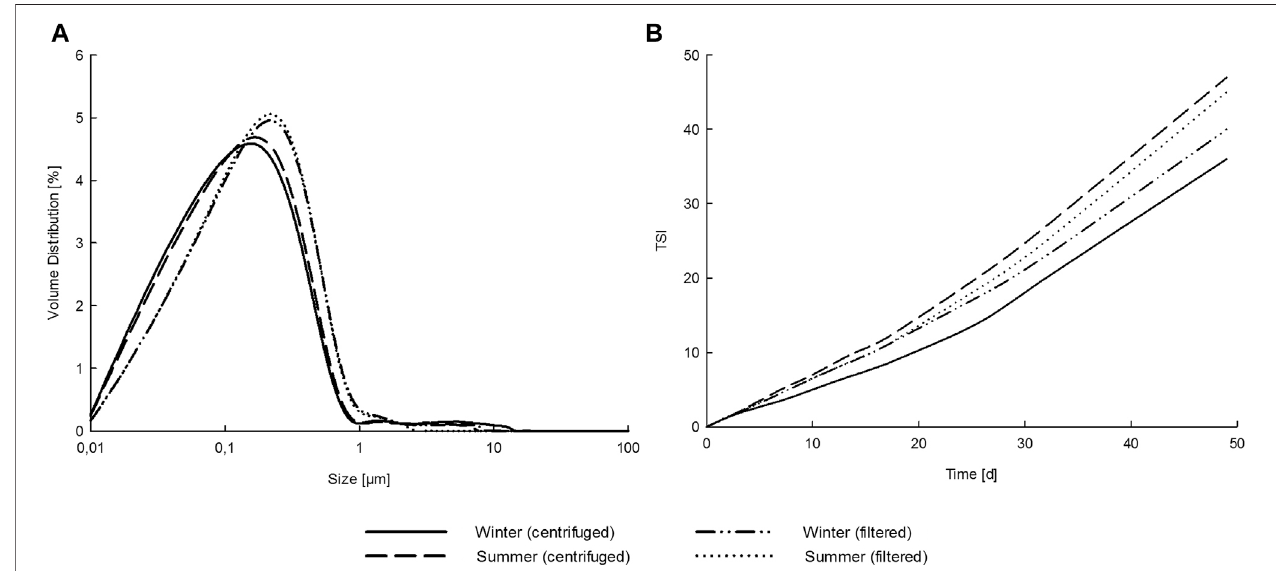
FIGURE 4 | Droplet size distribution after 8 weeks of storage (A) and Turbiscan stability index (TSI) as a function of storage time (B) of tree pruning residue liquor – hexadecane emulsions.